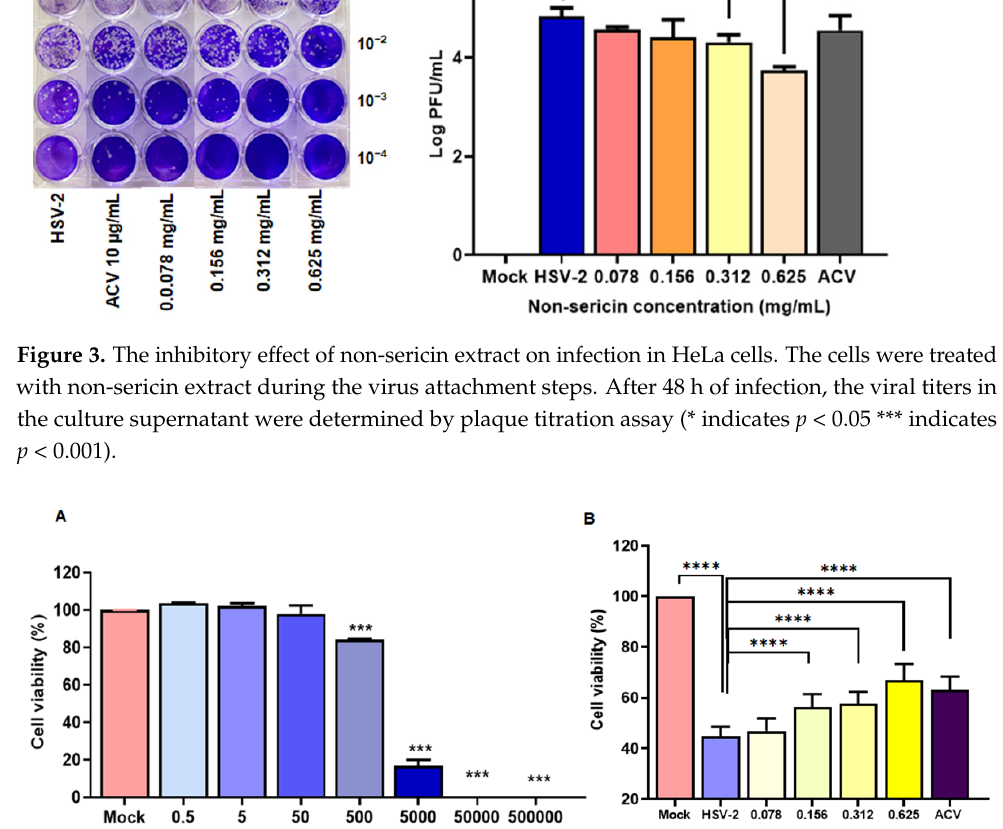
Figure 3. The inhibitory effect of non-sericin extract on infection in HeLa cells. The cells were treated with non-sericin extract during the virus attachment steps. After 48 h of infection, the viral titers in the culture supernatant were determined by plaque titration assay (* indicates p < 0.05 *** indicates p < 0.001).